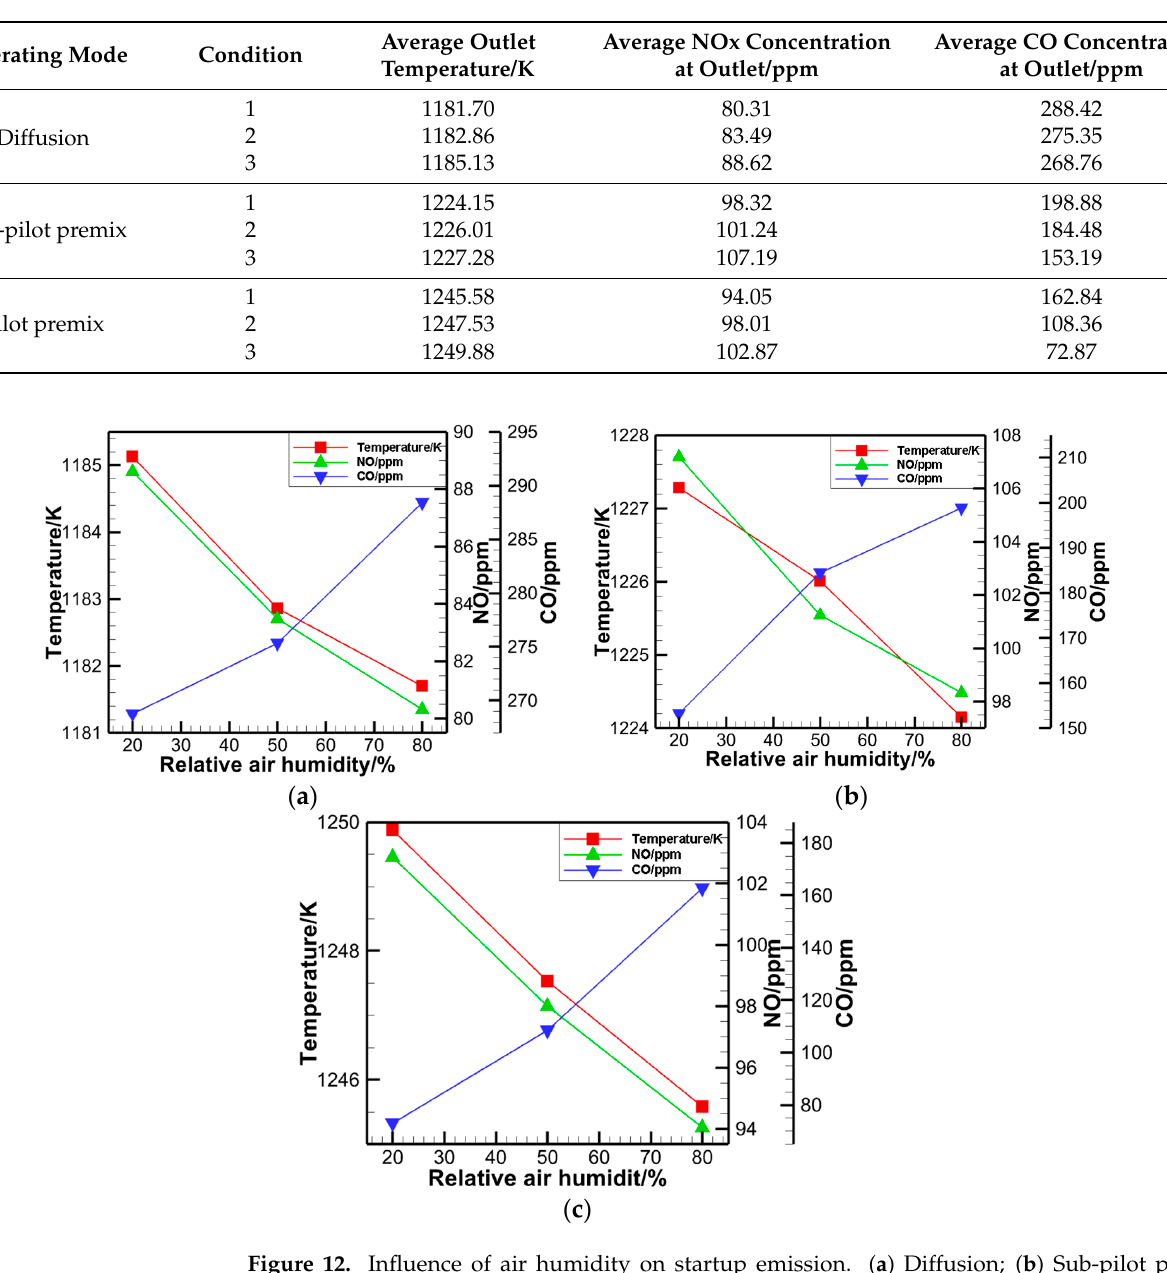
Table 10. Simulation results of humidity variation.